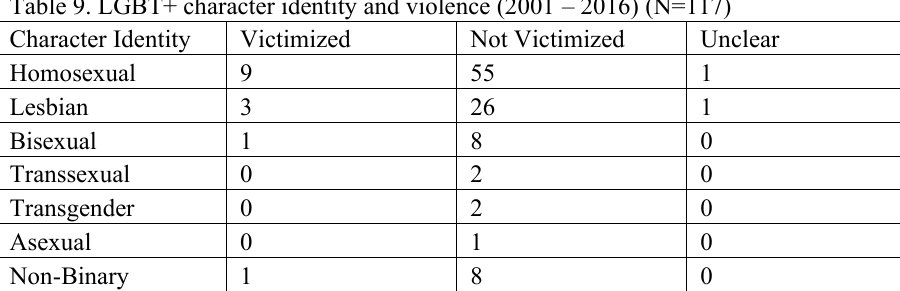
Table 9. LGBT+ character identity and violence (2001 – 2016) (N=117) Character